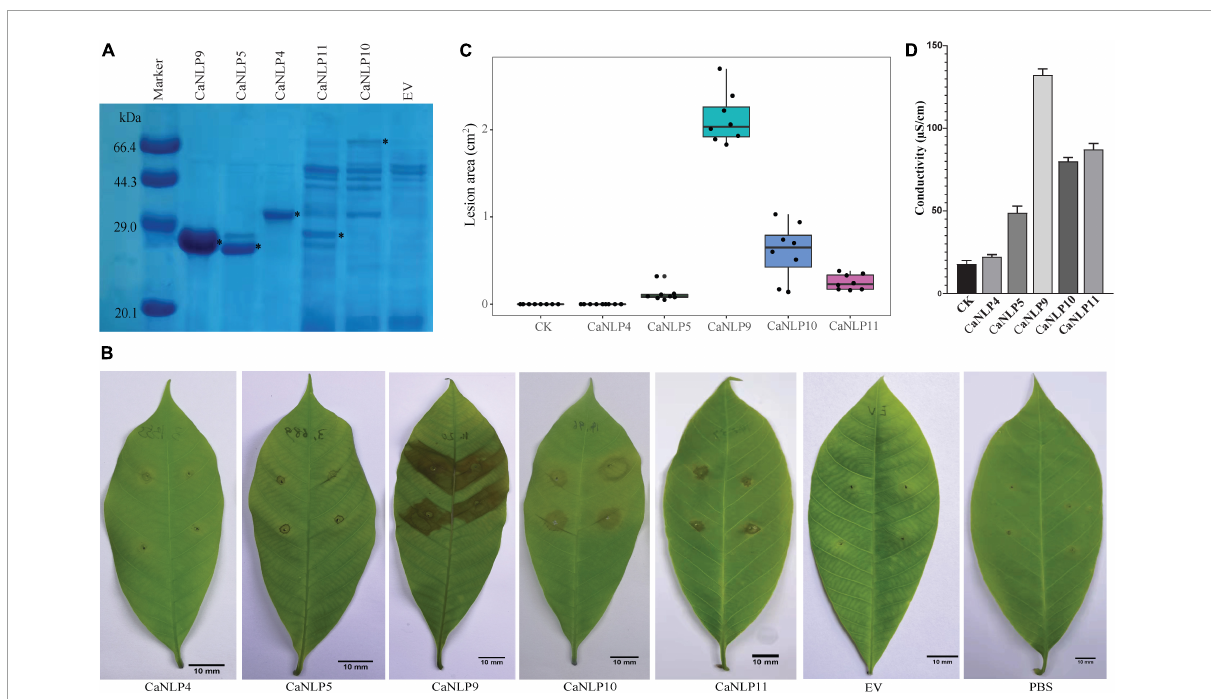
FIGURE2 Recombinant CaNLP proteins display cytotoxic activity against H. brasiliensis leaves. (A) SDS-PAGE analysis of CaNLPs stained with Coomassie Blue. Recombinant proteins were expressed in the E. coli BL21 (DE3) strain using the pET SUMO vector, and partially purified using Ni-NTA resin. Black asterisks indicate target protein bands. (B) Representative H. brasiliensis leaves infiltrated with partially purified CaNLPs. Pictures were taken at 4 dpi. (C) Lesion areas measured by ImageJ. Data were analyzed from 10 biological repeats. (D) Quantification of necrotic activity induced by CaNLP proteins in plants by electrolyte leakage